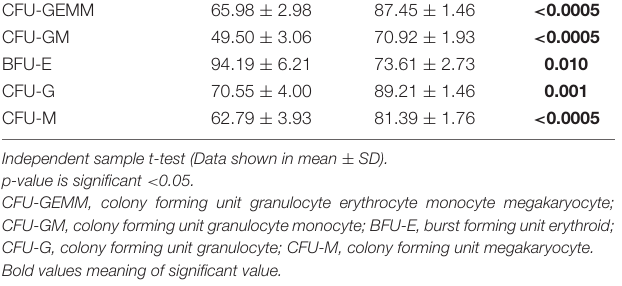
TABLE 5 | A comparison of progenitors counts in GDM and Control groups. Types of